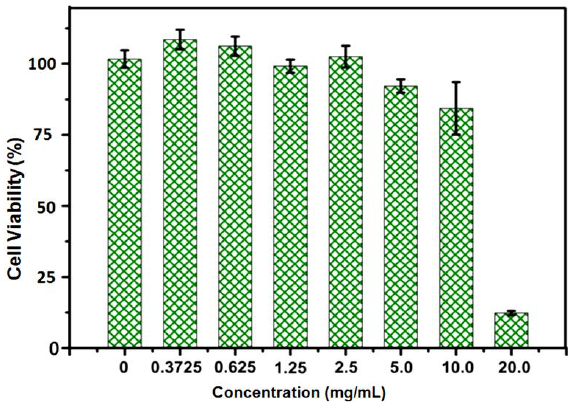
Figure 7. Cytotoxicity experiment of starch NSs. The values are the average of triplicate